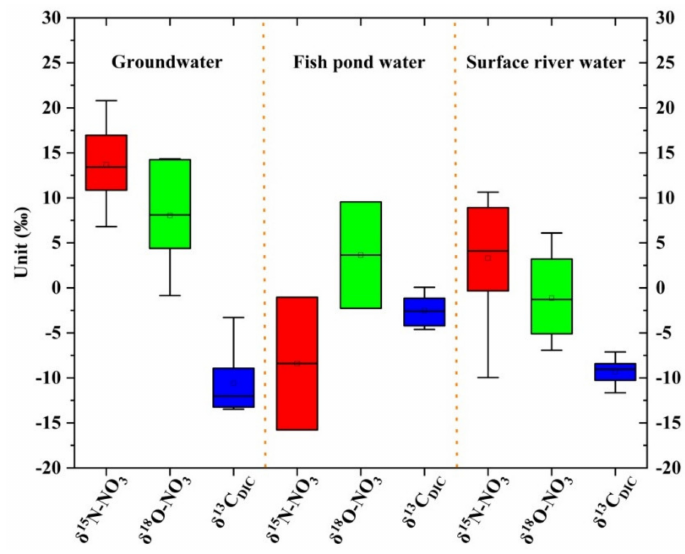
Figure 4. Characteristics of carbon, nitrogen, and oxygen isotopes in the study